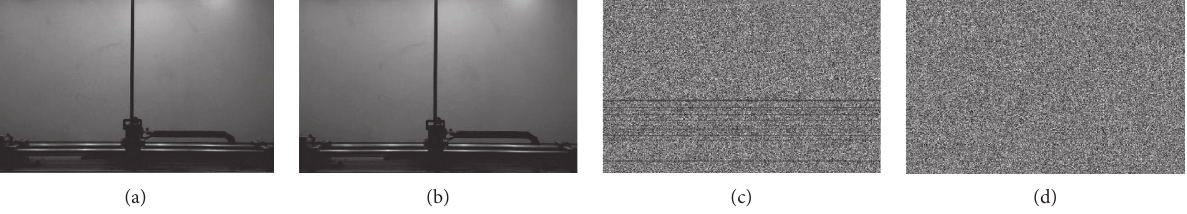
Figure 4: Key sensitivity analysis. (a) Original image. (b) Decrypted image: x x � 0 . 19940730 + 10 − 15 and μ � 3 . 999999. (d) Decrypted image: x 0